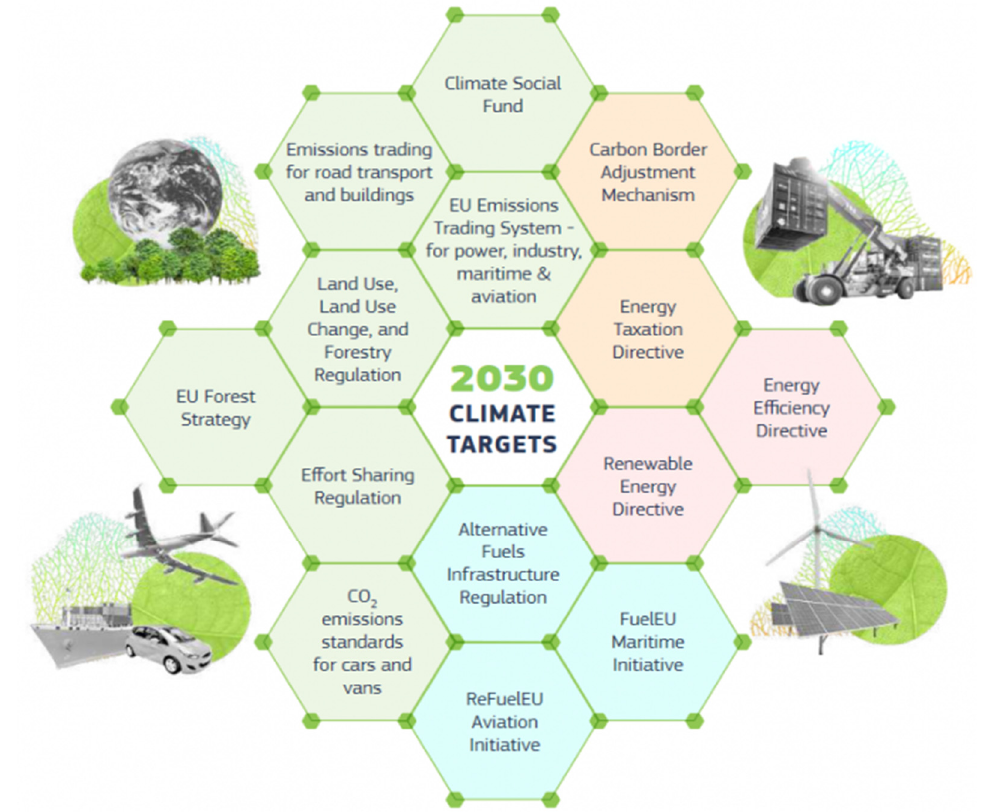
Figure 1. Fit for 55 EU [22].